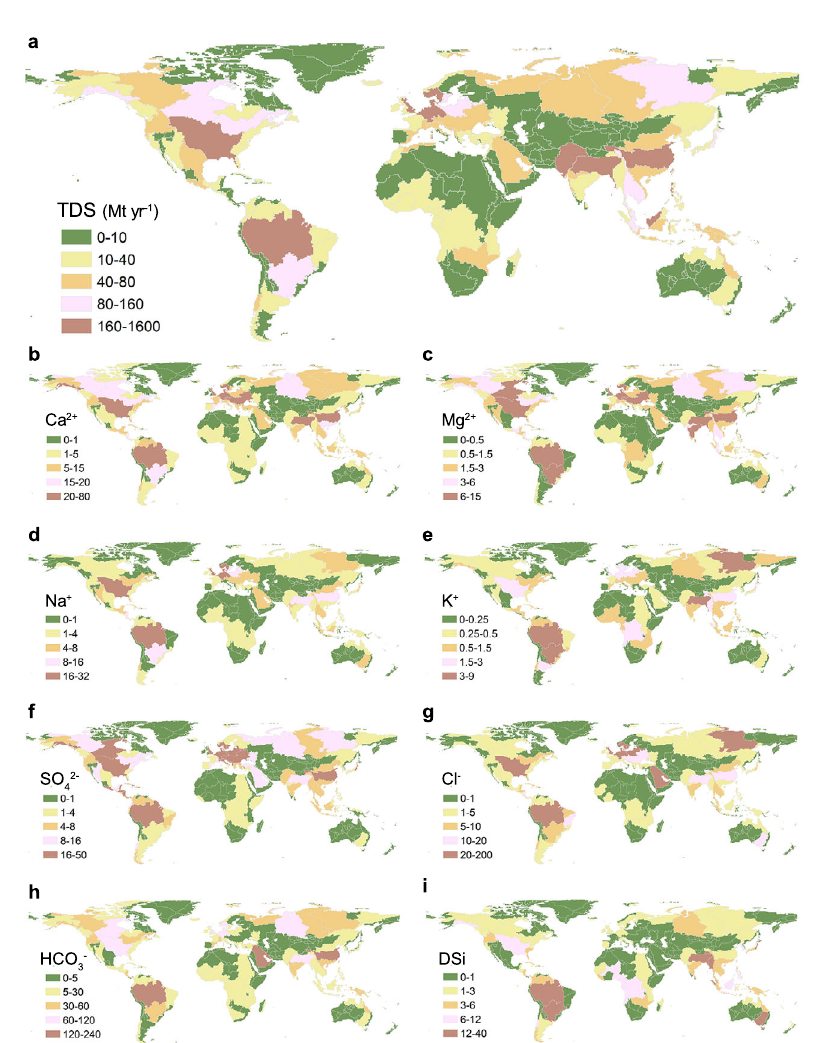
Fig. 2 Annual fl ux of total dissolved solids (TDS) and major solutes from rivers to oceans. a refers to TDS fl ux, b – i correspond to Ca 2 + , Mg 2 + , Na + , K + , SO 4 2 − , Cl − , HCO 3 − , and dissolved silica (DSi) fl